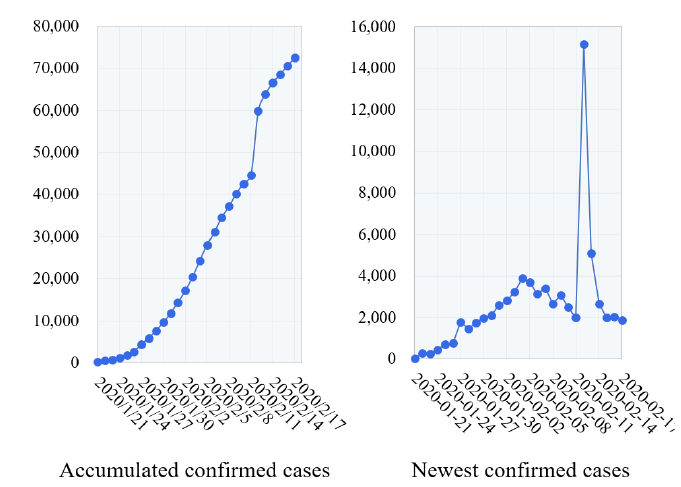
Figure 2. Confirmed COVID-19 cases extracted from microblogs from 21 January 2020 to 17 February